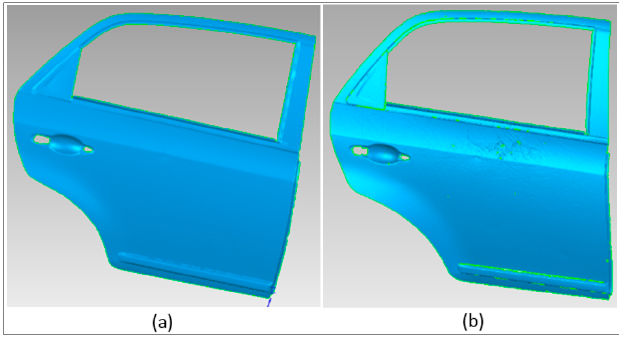
Figure 8. Data points obtained with laser scanner—( a ) best model; ( b ) worst model.